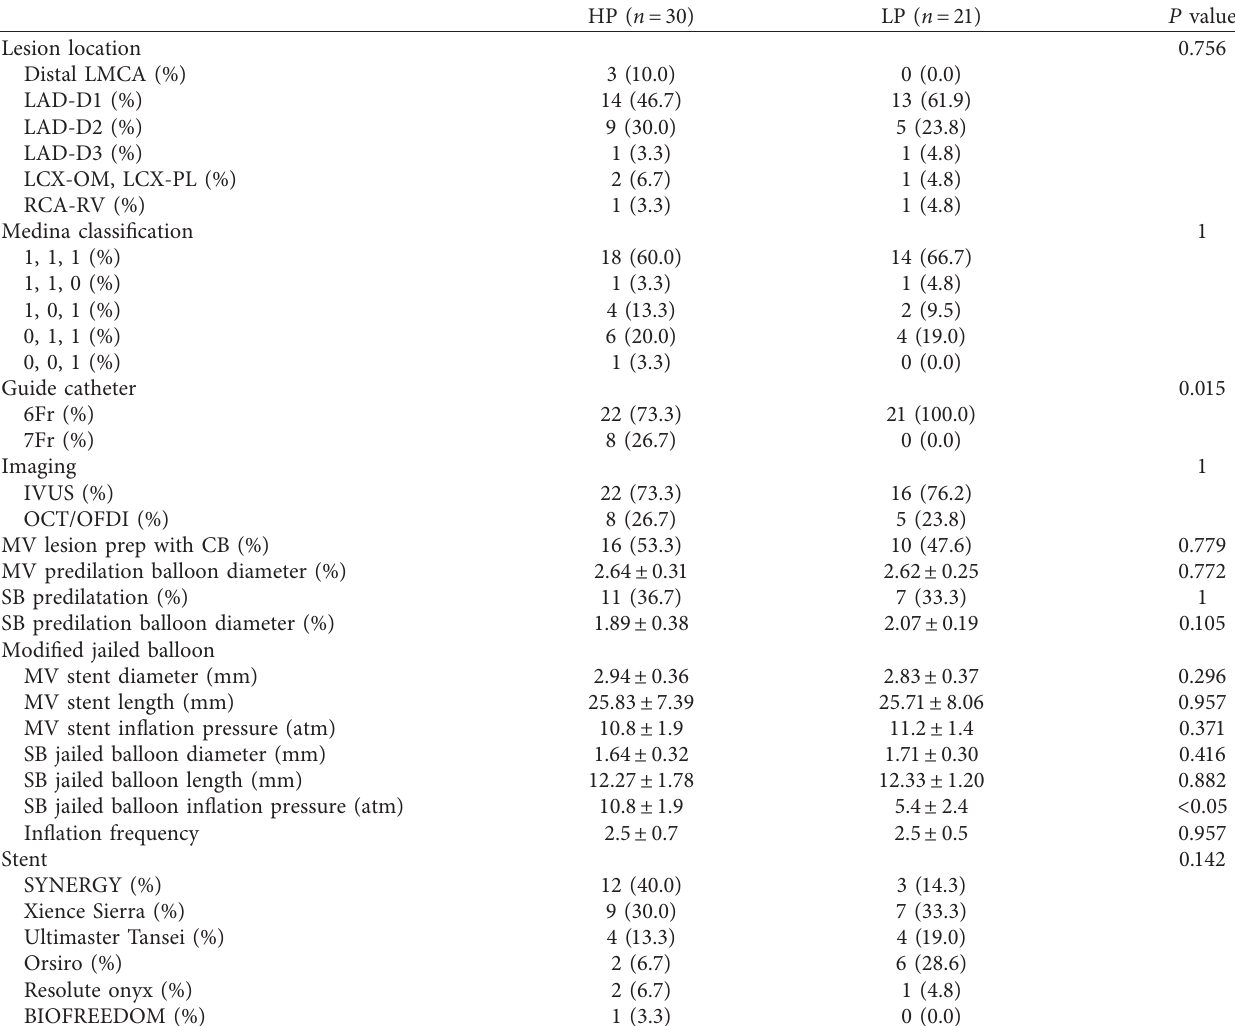
Table 2: Angiographic lesion and procedural characteristics of the study